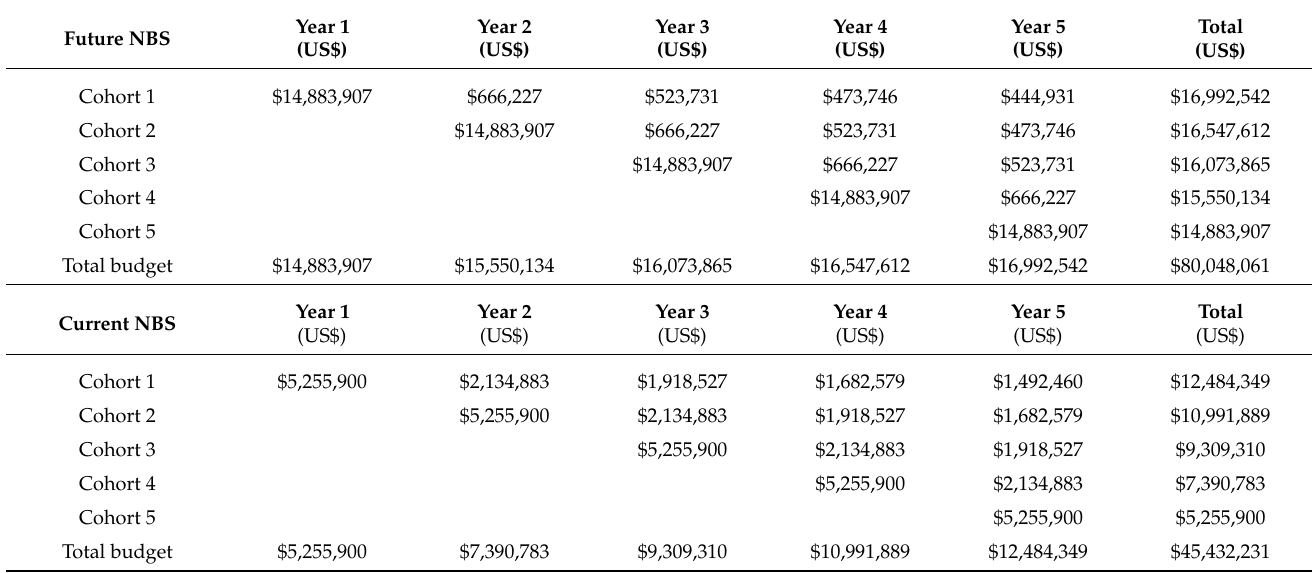
Table 3. Expected 5-year total budgets of future NBS with combined screening for SCID and SMA and treatment with early HSCT and gene therapy, compared to current NBS without screening for SCID and SMA and treatment with late HSCT and nusinersen (undiscounted US$ 2018 value). Future